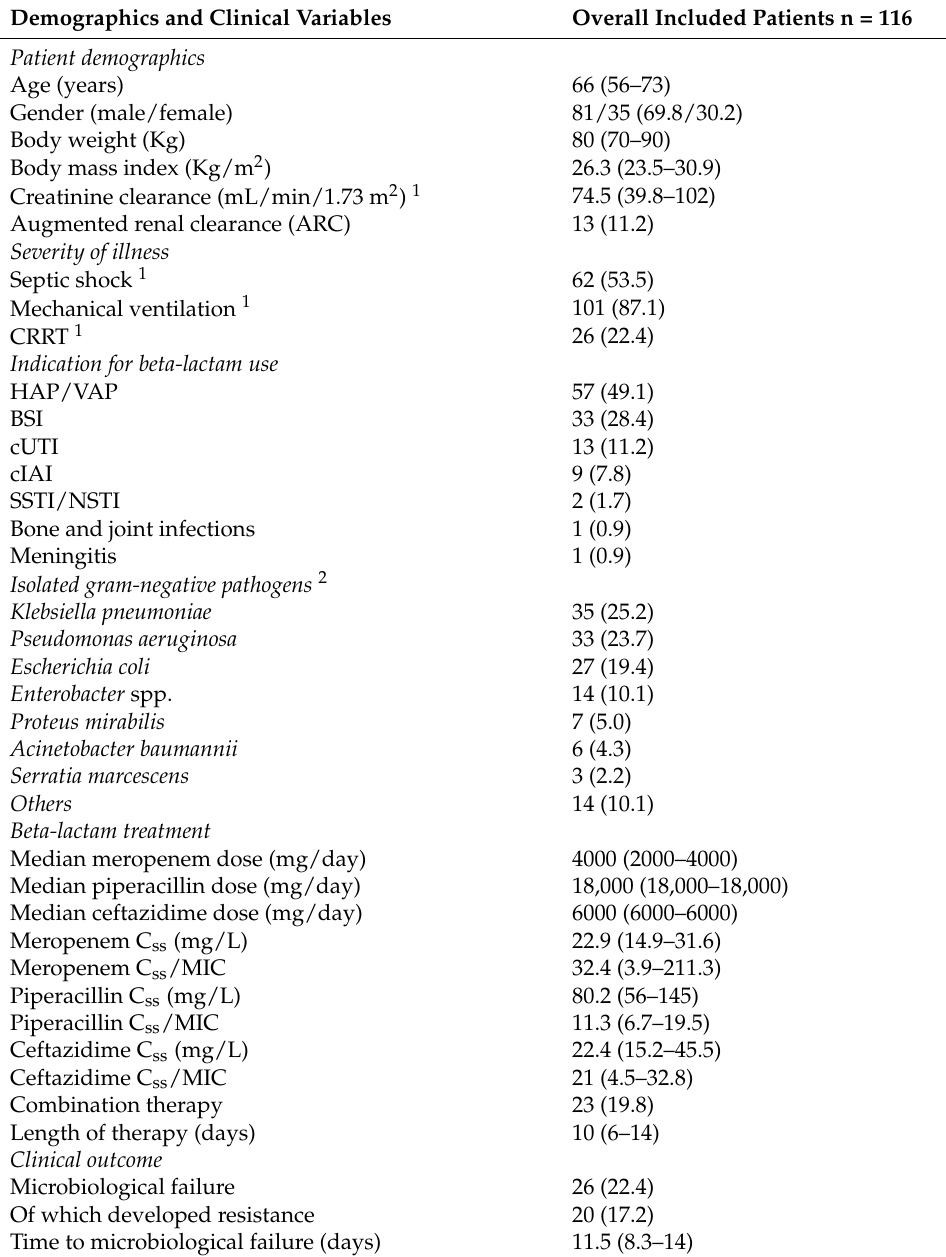
Table 1. Demographics and clinical characteristics of critically ill patients receiving continuous infusion beta-lactams for treating documented gram-negative